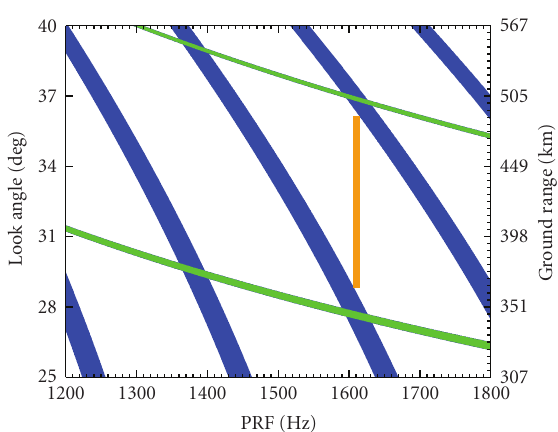
Figure 6: Timing (diamond) diagram for an orbit height of 650km and a transmit duty cycle of 8%. For a given PRF the diagram shows the restrictions on the receive window due to transmit instances (wide dark strips) and nadir echos (thin light strips).